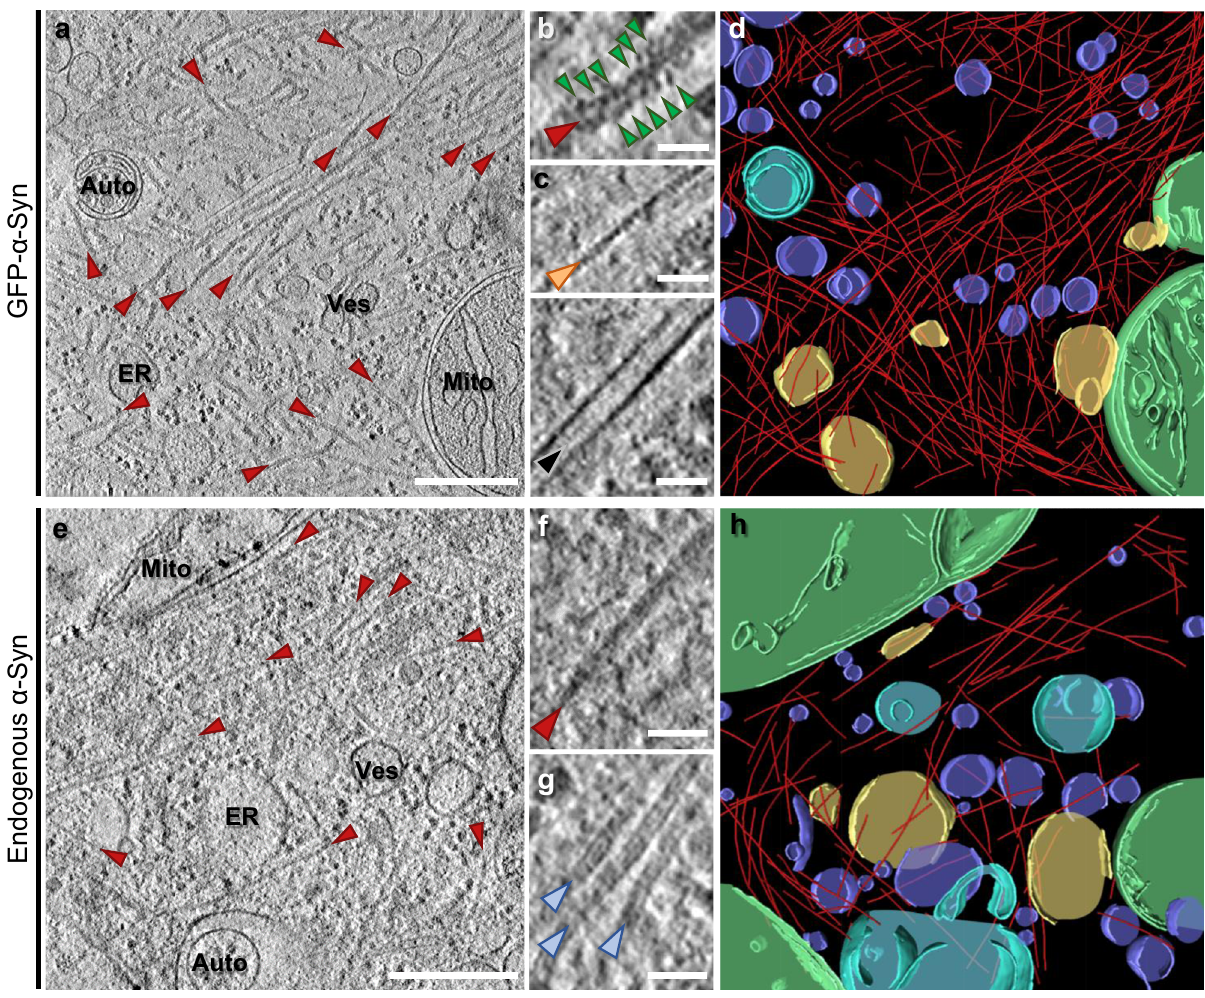
Fig. 1 Cryo-ET imaging of α -Syn aggregates seeded by PFFs in neurons. a A tomographic slice (thickness 1.8 nm) of an inclusion seeded by PFFs in a neuron expressing GFP- α -Syn. Auto; autophagosome, ER; endoplasmic reticulum, Mito; mitochondrion, Ves; vesicles. Fibrils are marked by red arrowheads. Scale bar: 350 nm. b Magni fi ed view of a fi bril with GFP-like densities (green arrowheads) decorating the fi bril core. Scale bar: 30 nm. c Magni fi ed views of an actin fi lament (orange arrowhead) and a microtubule (black arrowhead). Scale bars: 30 nm. d 3D rendering of the tomogram depicted in a showing α - Syn fi brils (red), an autophagosome (cyan), ER (yellow), mitochondria (green), and various vesicles (purple). e A tomographic slice (thickness 1.4 nm) of an inclusion seeded by PFFs in a neuron expressing p62-RFP. Scale bar: 350 nm. f Magni fi ed view of a fi bril. Note that fi brils in cells not expressing GFP- α - Syn are not decorated by GFP-like densities. Scale bar: 30 nm. g Magni fi ed view of neuro fi laments (blue arrowheads). Scale bar: 30 nm. h 3D rendering of the tomogram depicted in e . The number of tomograms and biologically independent cryo-ET experiments is listed in Supplementary Table 1. Representative images are